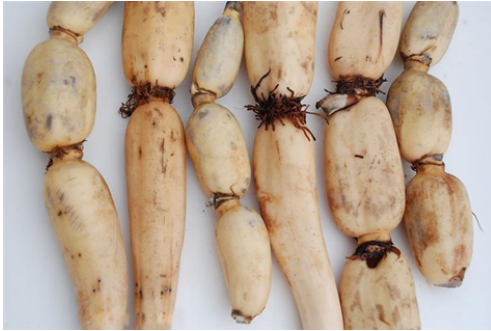
Figure 1. Image of lotus